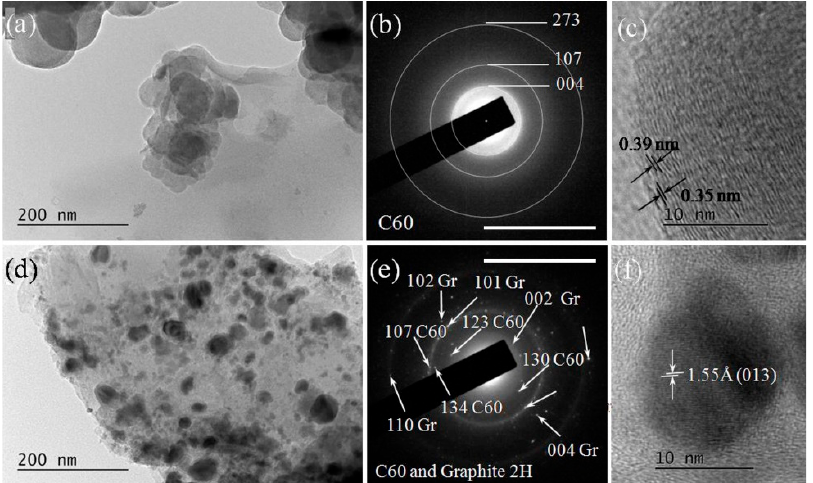
Figure 12. ( a ) Spherically agglomerated amorphized carbon after a 266 nm laser irradiation of HQ